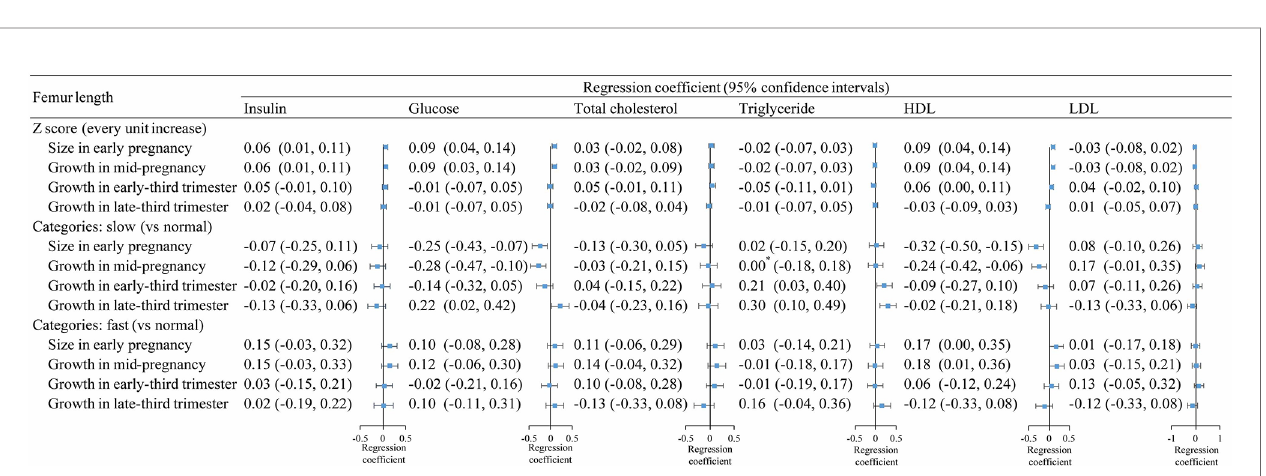
FIGURE 3 | Association between fetal femur length growth in different periods and cord blood metabolic factors. *, >0 and